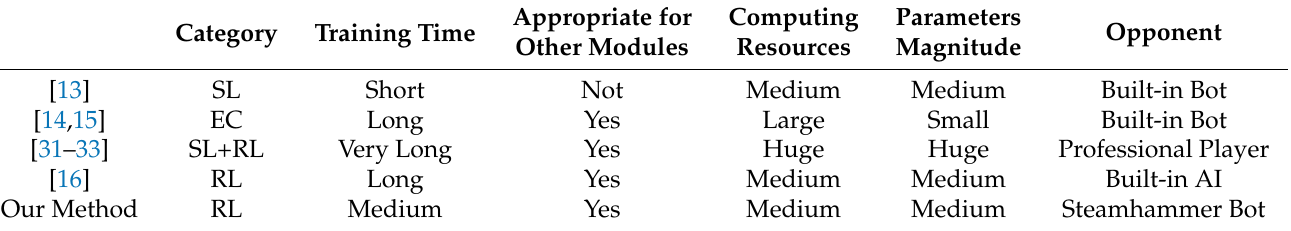
Table 1. The comparison of the methods to learn